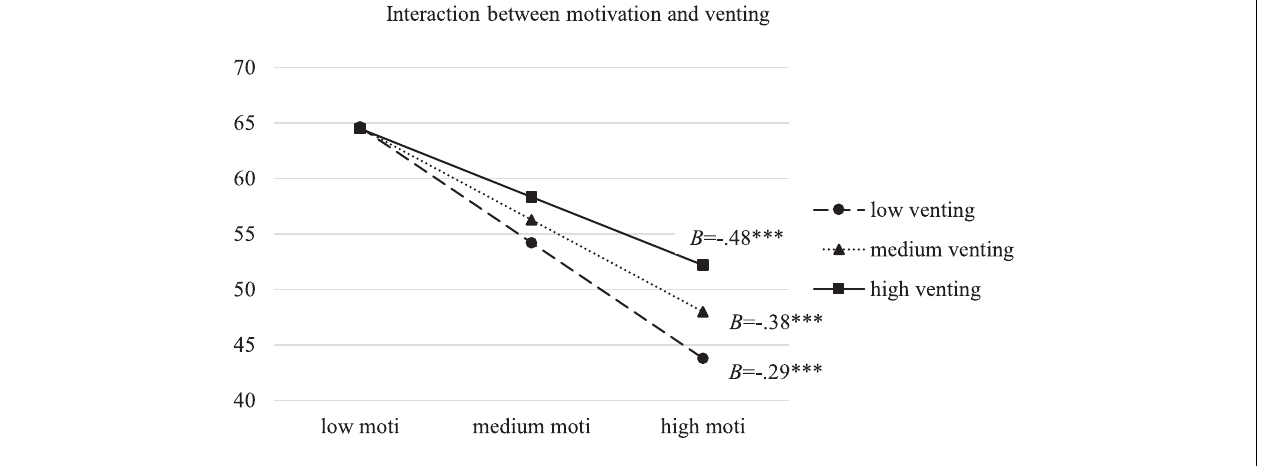
FIGURE 4 | Moderation effect of venting between motivation and burnout. moti: motivation; ∗∗∗ p <